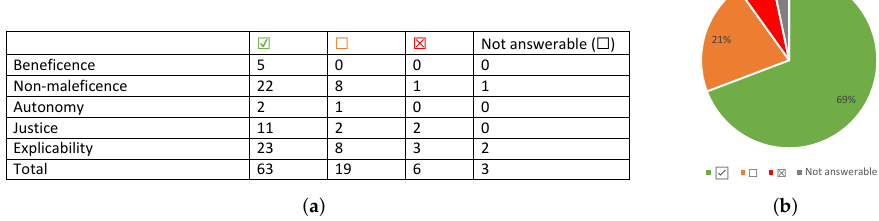
Figure 5. Results of a comparison of the analysis of the media on Amersfoort with the application of the proposed framework by the municipality of Amersfoort on whether questions in the framework could be answered with a yes, maybe, no, or were not answerable. ( a ) Exact numbers. ( b ) Percentages.